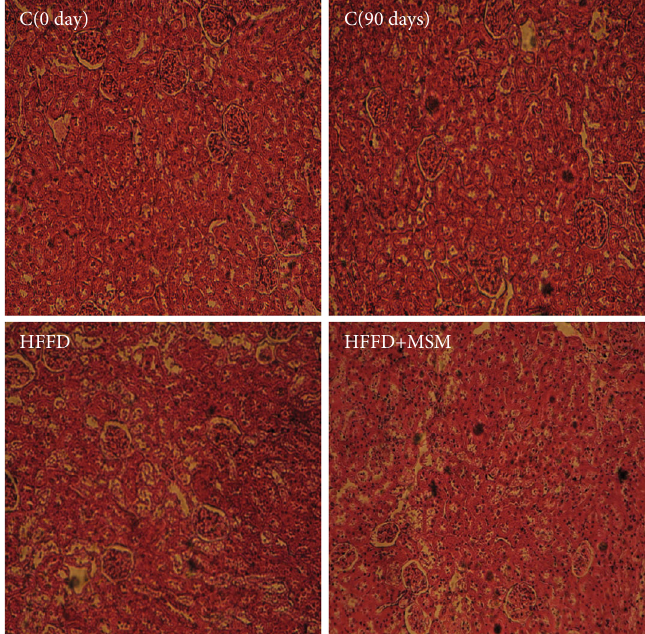
Figure 5: C and C : normal rat liver; HFFD rat liver: sinusoidal congestion and fatty degeneration in the form of fat lake; HFFD 0day 90days + MSM : diabetic treated with MSM — a positive e ff ect was observed (H&E